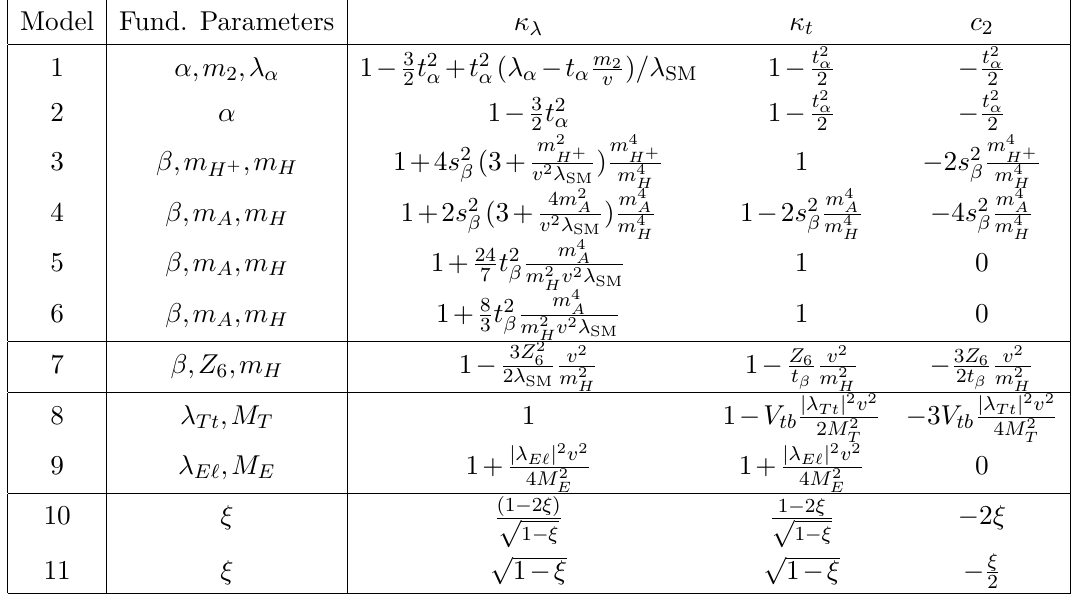
Table 7 . Effective couplings in terms of physical parameters of various explicit models. Here, α is the mixing angle between the two scalars, while β = arccos( v 1 /v ) is the arccosine of the ratio of the vev of the (first) doublet and the electroweak vev v ≈ 246 GeV, and we defined s x ≡ sin x ( t x ≡ tan x ). A common mass m H is assumed for the heavy scalars, besides for H + and A in models 3-6, with masses m , m A . Beyond that, m 2 is the coefficient of the triple-singlet coupling and H + λ α that of the bi-quadratic scalar term, while Z 6 multiplies | H 1 | 2 H † H 2 in the 2HDM. Moreover, 1 M T and M E are the masses of the heavy vector-like quark and lepton, respectively, and λ Tt , λ E‘ are the coefficients of their (Yukawa-type) couplings with the SM fermions, mediated by the Higgs. Finally, ξ ≡ v 2 /f 2 parametrizes the composite Higgs non-linearity, with f the Pseudo-Goldstone decay constant. See references given in table 5 for more